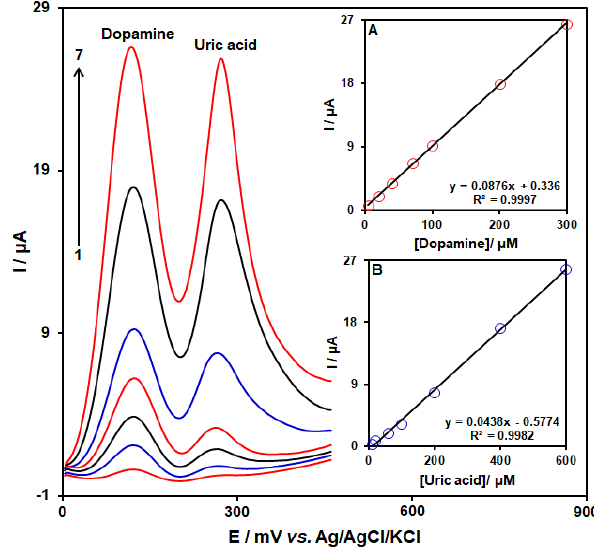
Figure 10. SWVs of CoMOF-GO/1-M,3-BB/CPE in PBS (0.1 M, pH = 7.0) with variable DA concen- trations ( 1–7 : 5.0, 20.0, 40.0, 70.0, 100.0, 200.0, and 300.0 µ M) and UA ( 1–7 : 10.0, 20.0, 60.0, 100.0, 200.0, 400.0, and 600.0 µ M). Insets: ( A ) plot of peak current versus DA concentration, ( B ) plot of peak current versus UA concentration.